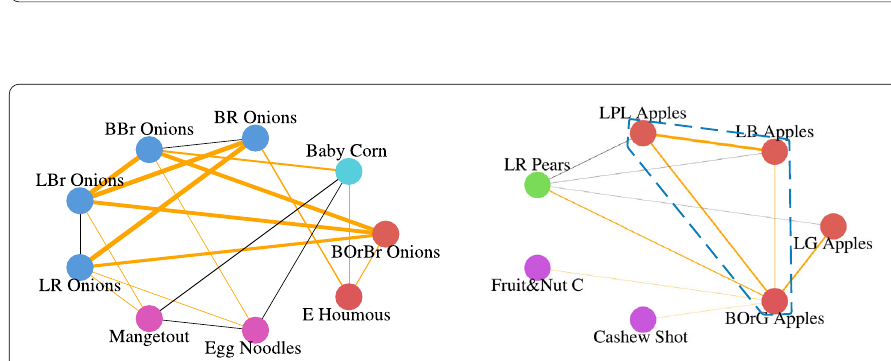
Figure 9 Internal structure of the substitute roles of onions (4) ( left ) and of apples (23) ( right ), with product nodes connected by both the complementarity scores ( W ( c ) ij ) (in black) and the substitutability scores ( W ( s ) ij ) (in orange), where the line thickness corresponds to how high the scores are, and products in the same L1 category are shown in the same colour